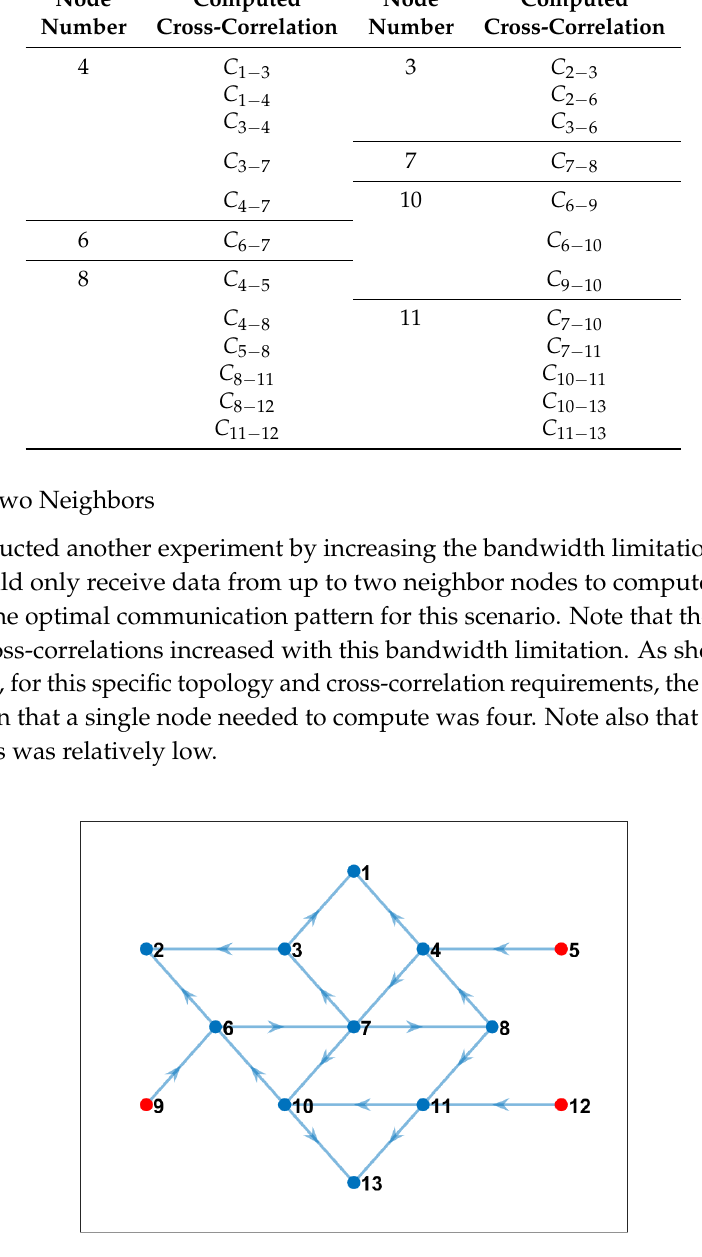
Figure 10. Communication pattern using the proposed model when we considered that one node could only receive data from up to two neighbor nodes (blue nodes are nodes that computed cross-correlation; red nodes only sent data to the corresponding network). Nodes that computed